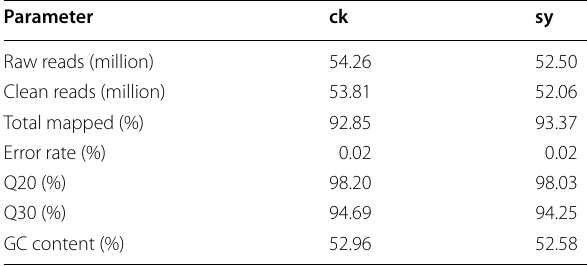
Table 1 Profile of the transcriptome sequence data